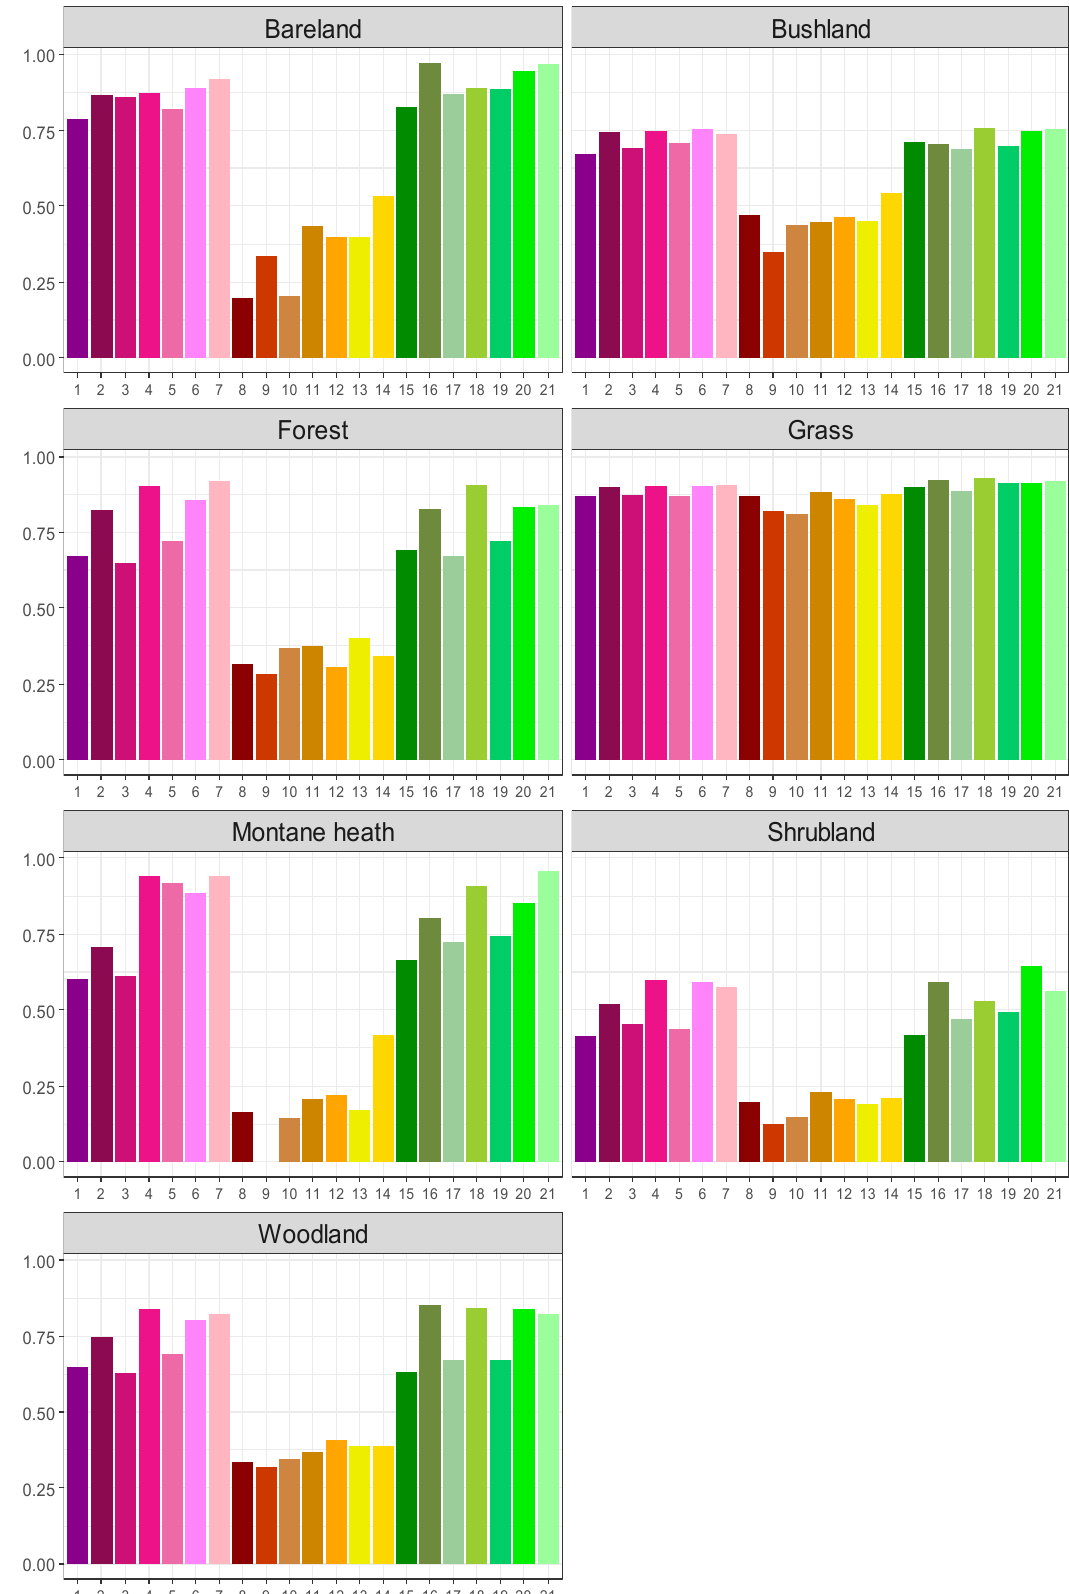
Figure 6. User’s accuracy for different land cover types and models. Coding of model combinations in Table 2.